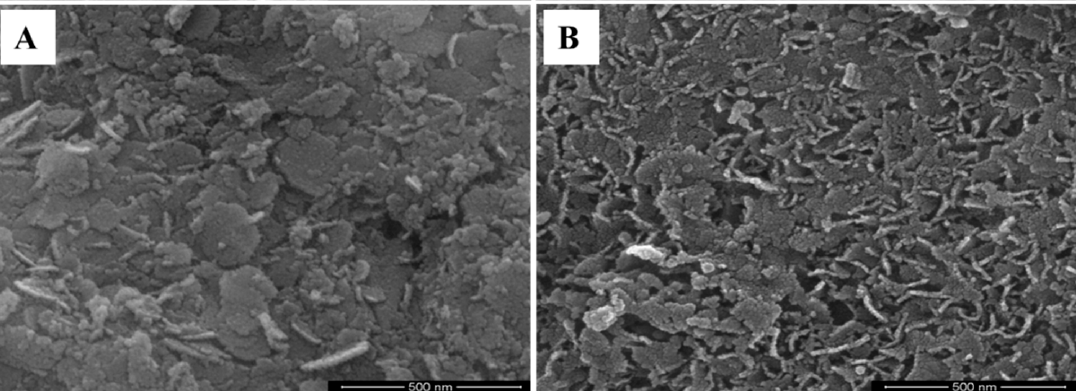
Figure 3. HR-SEM analysis of Sr-doped CoAl 2 O 4 nanoparticles. ( A ) Porous and ( B ) spherical morphology. 3.3. Elemental Examination Using Energy-Dispersive X-ray Spectroscopy The energy-dispersive X-ray spectroscopy based on the Photon flanking X-ray exami- nation of Co 1 − x Sr x Al 2 O 4 (0 ≤ x ≤ 0.5) nanomaterials revealed their chemical compositions, and are accordingly depicted in Figure 4. The elemental presence of Co, Sr, Al, and O,